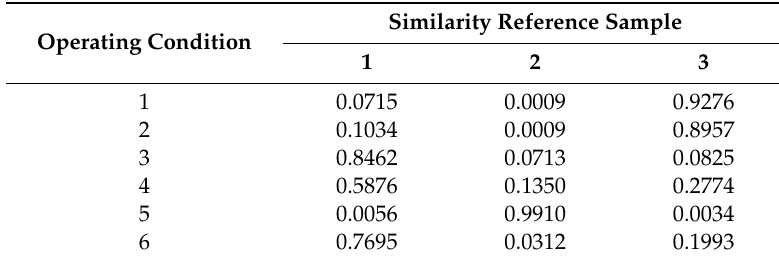
Table 2. The weights of each operating condition.